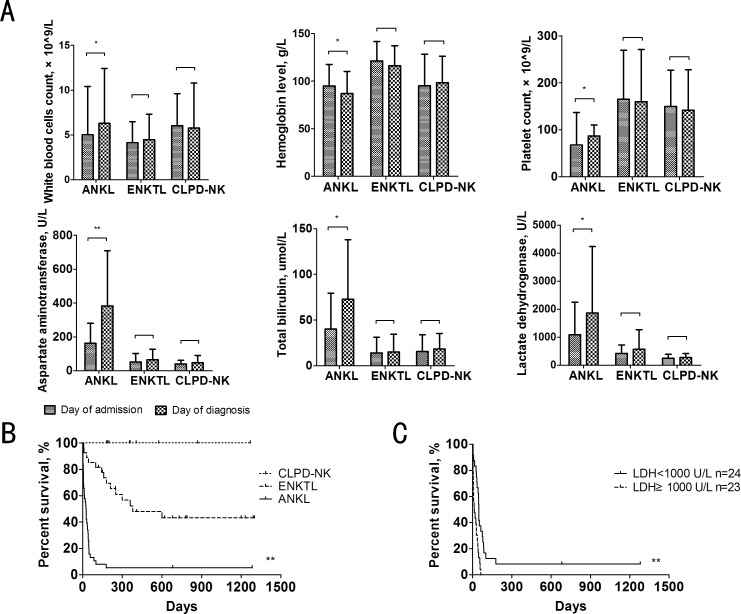
ANKL developed aggressively and had a low OS.(A) Laboratory test results were monitored from the day of admission to the day of diagnosis for all three types of NK cells diseases. The significantly dynamic data reflected the rapid deterioration of the patients with ANKL compared to those with the other two disease types. * p<0.05, ** p<0.01. (B) Prognosis for the three evaluated NK cell diseases, as analyzed by the Kaplan-Meier method. The median OS for ANKL was 27 days (range, 2–1283 days), whereas that for ENKTL was 249 days (range,8–1300 days) and that for CLPD-NK was 360 days (range,180–1270 days). The mortality rate for ANKL, ENKTL, and CLPD-NK were 10.5%, 48.1% and 0% respectively. * p<0.05, ** p<0.01. (C) OS stratification by serum LDH level (＜1000 U/L vs≥1000 U/L) for the patients with ANKL, as analyzed by the Kaplan-Meier method. * p<0.05, ** p<0.01.